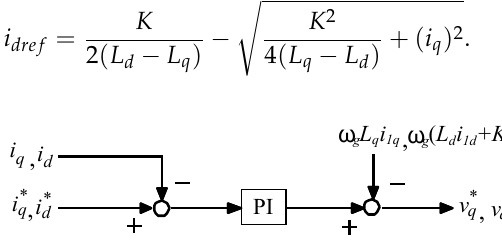
Figure 4. Generator side converter control